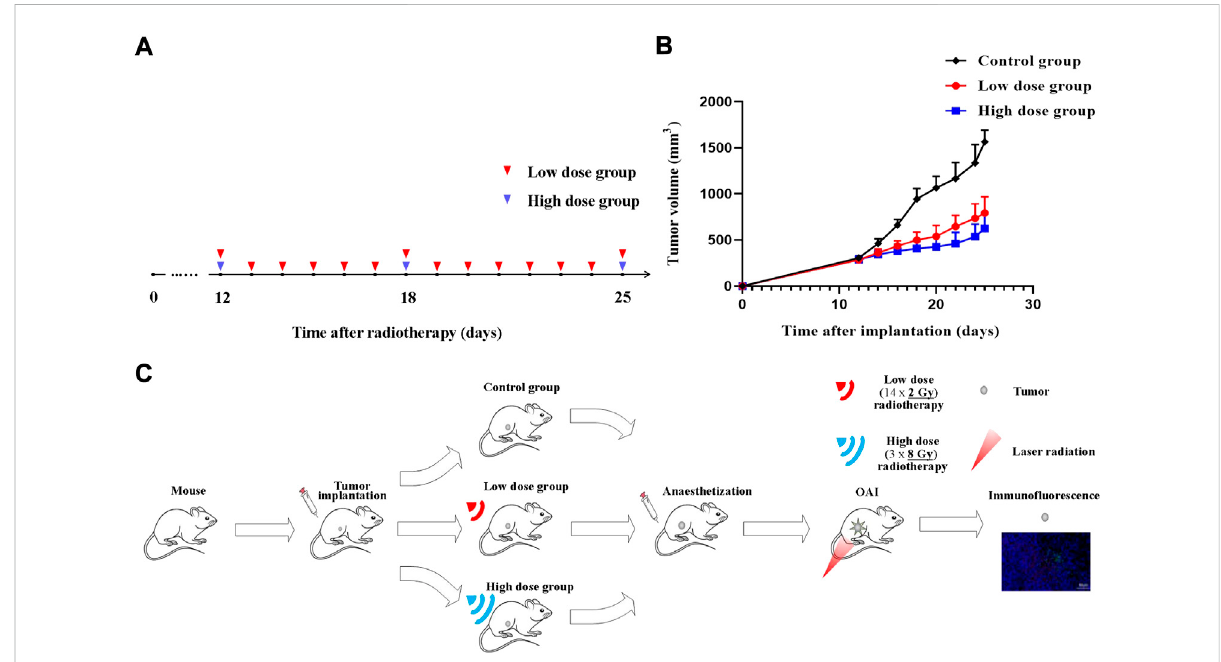
FIGURE 1 Radiotherapy protocol during tumor growth process. Experiment schedule (A) and dynamics of 4T1 volume after single-dose irradiation at different doses (B,C) Illustrative overview of experimental protocols. Time point of tumors radiotherapy is indicated by blue triangle (high dose) and red triangle (low